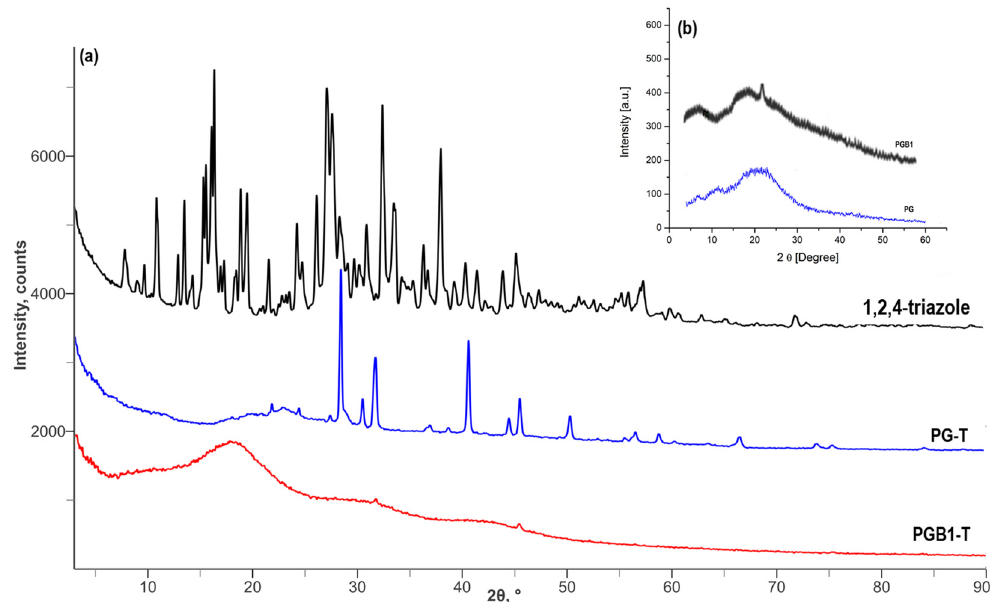
Molecules 2021 , 26 , x FOR PEER REVIEW 11 of 25